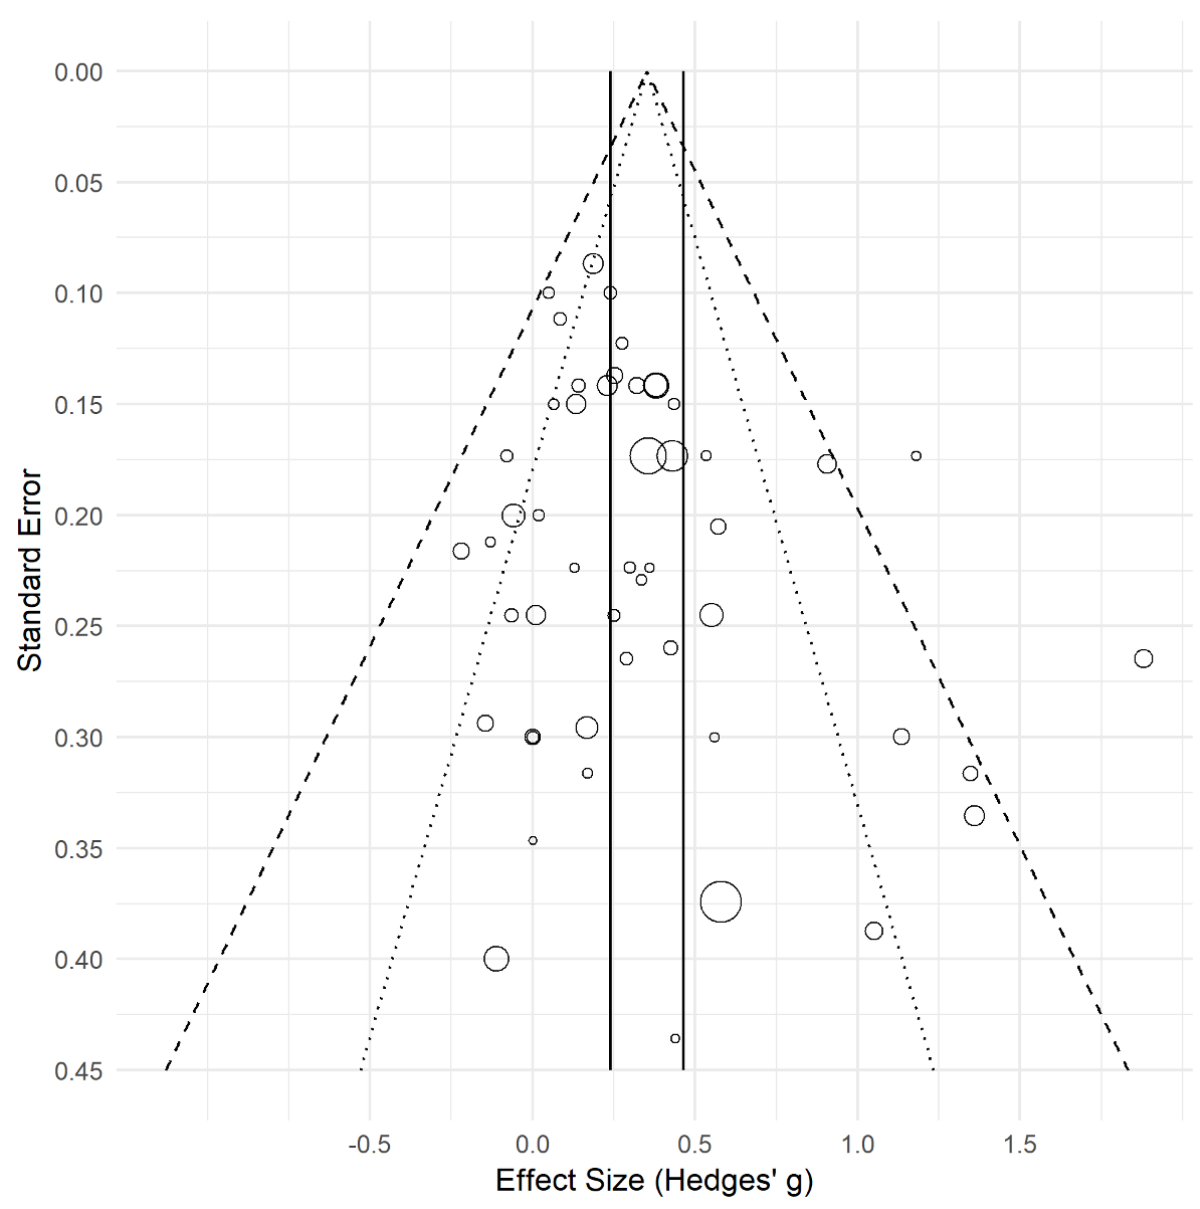
Figure 5. Funnel plot to assess publication bias. Point size indicates the number of participants in each study. The dotted and dashed lines show a 95% and 99% credibility region respectively and the full lines represent a 95% CI for the summary